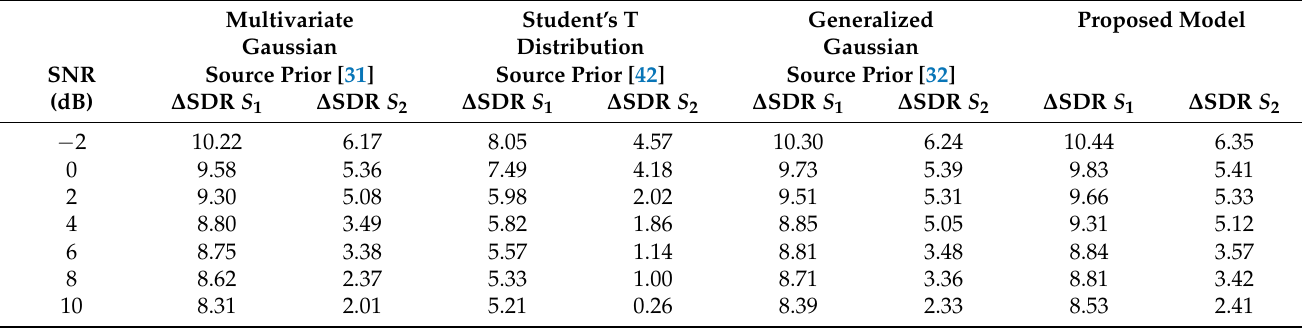
Table 1. Average SNR results for the first proposed model shown in Figure 1 with variable SNR for multistage BSS models having different source priors.